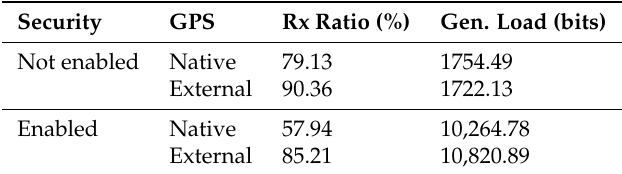
Table 5. Successful reception ratio (Rx Ratio) and load generated per packet (Gen. Load) for the UMB protocol, with and without enabling security services in the platform.